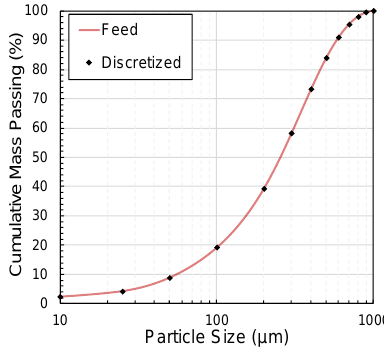
Fig. 2. PSD of the granite sand powder.